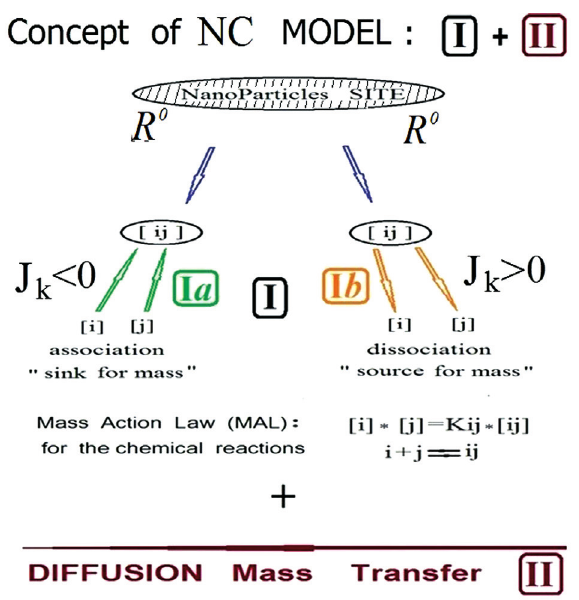
Figure 2 Scheme of mass “ Transformations ” inside bifunctional NC matrix at the active nanosites ( R 0 , Me 0 ): ( I a ) – association stage of MAL reactions (left ); ( I b ) – dissociation stage of MAL S ( right ): ( I ) Selectivity; ( II ) multicomponent diffusion mass transfer along NC pores: (Figure 1B, 2). Fluxes J for mass transformations.